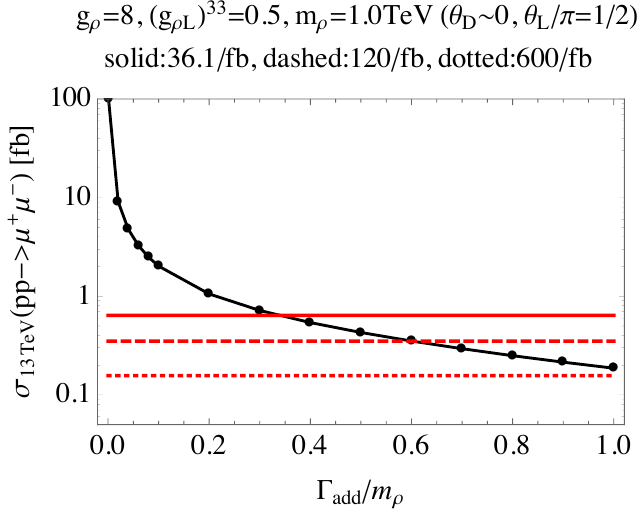
Figure 8 . The dimuon resonant production cross section for the target CFVs ( (cid:26) 3 and (cid:26) 0 ) at (1) (1) 0 p LHC with s = 13 TeV as a function of a possibly added width term (common for two CFVs) nor- malized to the mass m (cid:26) , for m (cid:26) = 1 TeV, g (cid:26) = 8 , g 33 = 0 : 5 (and (cid:18) D (cid:24) 0 , (cid:18) L = (cid:25)= 2 ). The horizontal (cid:26)L solid, dashed and dotted lines (in red) respectively correspond to the current 95% C.L upper limit placed by the ATLAS group with the integrated luminosity L = 36 : 1 fb (cid:0) 1 [179], and the expected upper bounds at L = 120 fb (cid:0) 1 and L = 600 fb (cid:0) 1 estimated just by simply scaling the